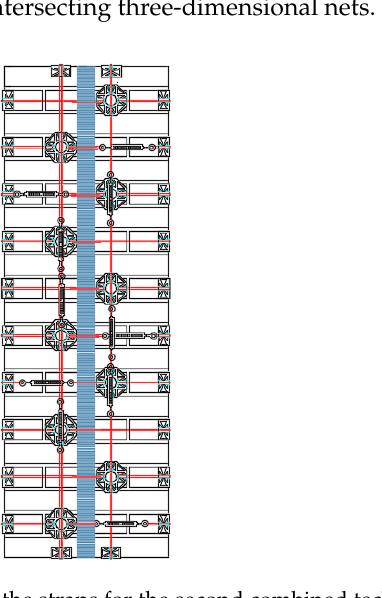
Figure 14. The fastening system along the lateral face of the brick wall (23 cm). Figure 15. Diagram of laying the bricks for ( a ) the odd rows and ( b ) the even rows (all the measurements in cm) [1]. 3. Experimental Program 3.1. Bricks and Mortar The bricks and mortar of the experimental program are the same as those of the experimentation on the first combined technique [1]. Their mechanical characterizations complied with UNI EN 772- 1 [42] and UNI EN 1015-11 [43], respectively. Tables 1 and 2 show the results of the mechanical characterization on the bricks and the mortar, which is of the M20 type.